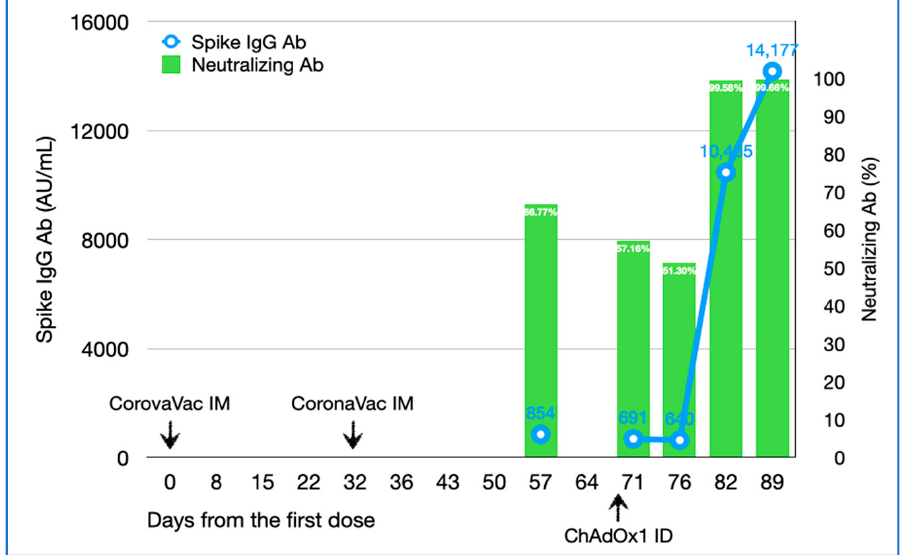
Figure 1. Spike immunoglobulin G and neutralizing antibody levels after the two intramuscular CoronaVac vaccinations and one intradermal ChAdOx1 vaccination. The green bar graphs present neutralizing antibody levels (%) whereas the blue line graph presents spike IgG levels (AU/mL). Ab, antibody; ID, intradermal; IM, intramuscular; IgG, immunoglobulin G.